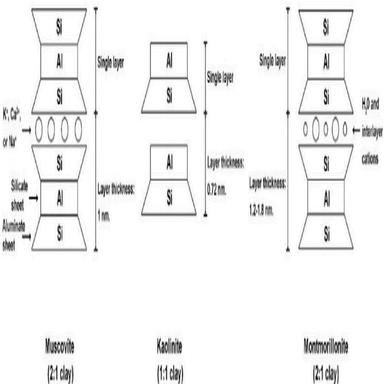
Diagram showing the structure of muscovite, kaolinite, and montmorillonite, adapted from Ref..